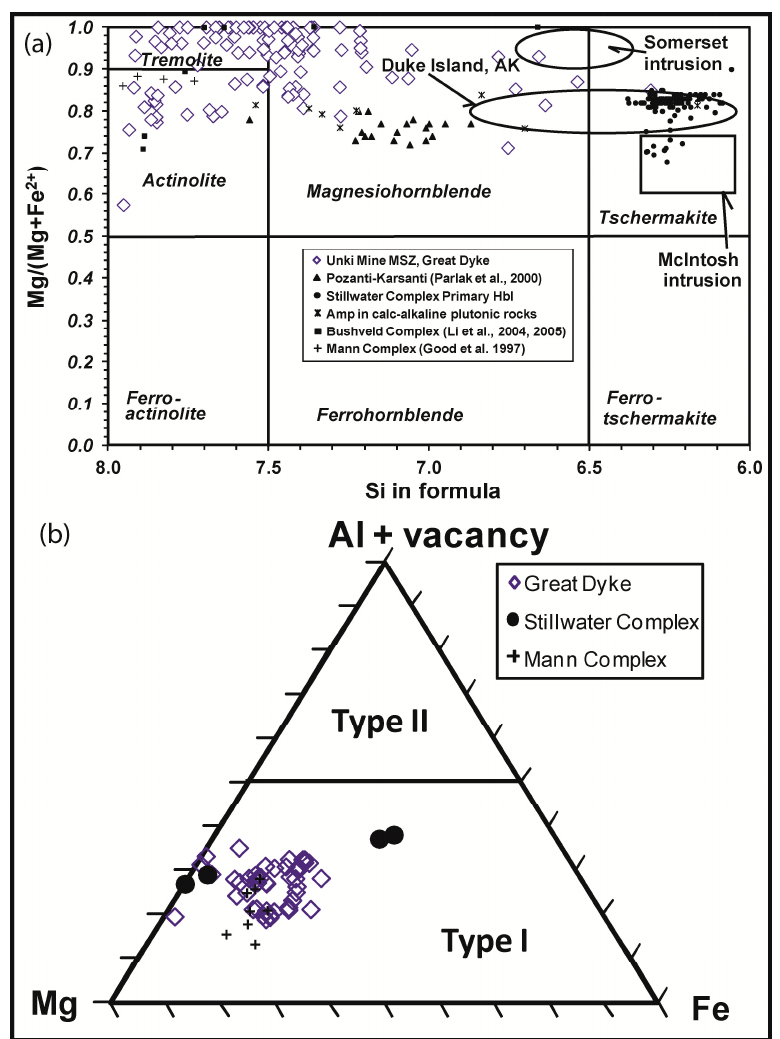
Figure 18. ( a ) Calcic amphiboles from the present study compared those from other intrusions